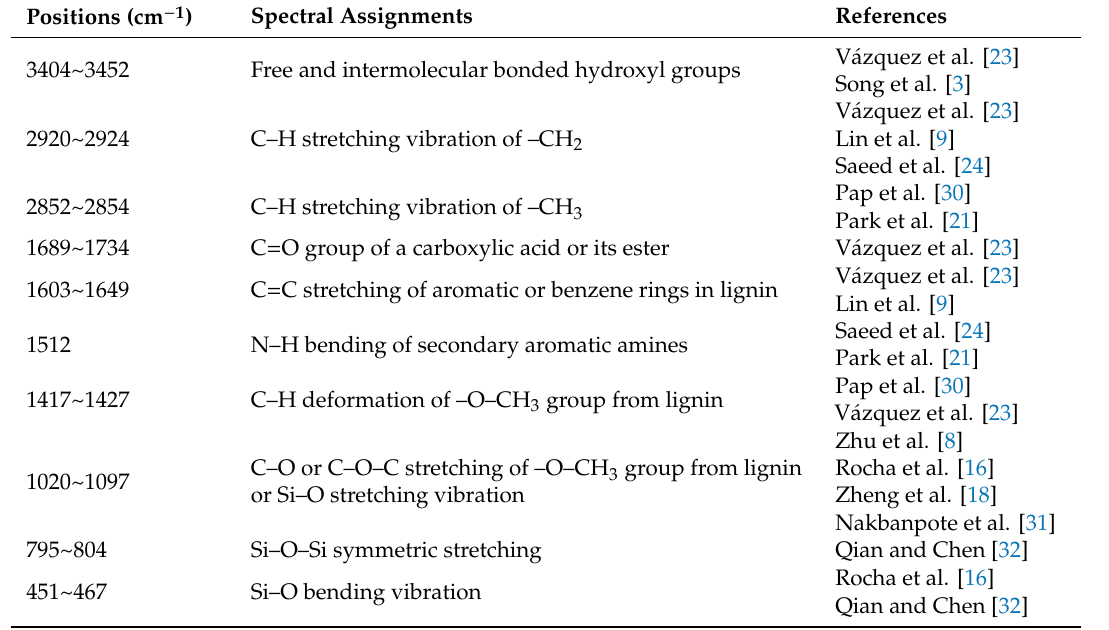
Table 1. Positions and Spectral Assignments of Cd(II) Adsorbed by the Four